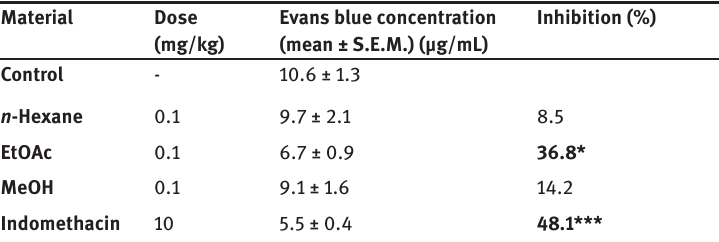
Table 2: Effects of test materials on increased vascular permeability induced by acetic acid in mice. Material